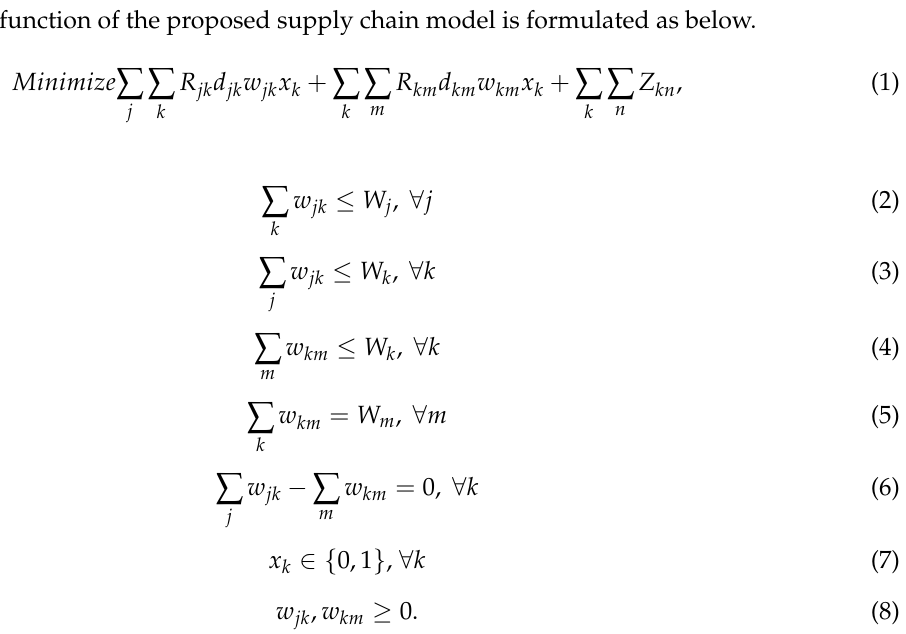
Figure 2. Flow of power transmission process.